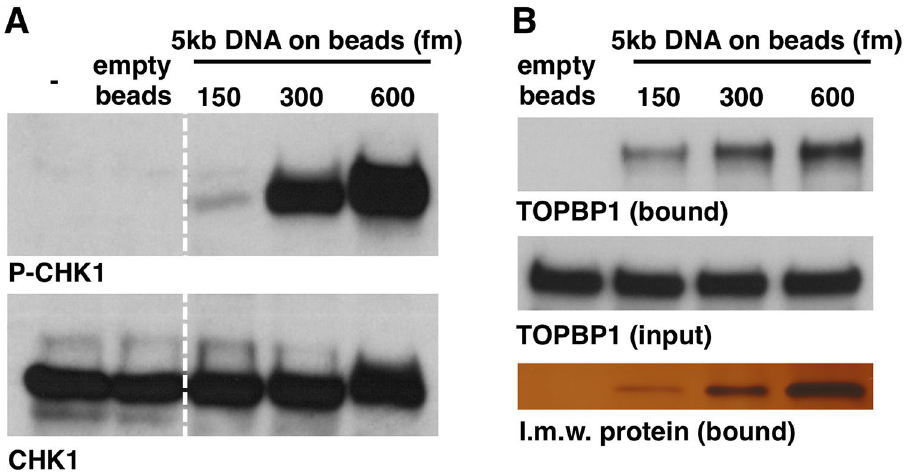
Figure 4. A DMAX-based DSB binding assay. ( A ) dsDNA (5kB) was coupled to magnetic streptavidin beads and then added to HSS at the indicated concentration of DNA. The sample labeled “–” received no beads. The sample labeled “empty beads” received only magnetic streptavidin beads. After a 60-min incubation samples were taken and probed for P-CHK1 and total CHK1. The dashed white line on the blots demarcates a lane from the original image that was removed because it is irrelevant. All samples shown were run on the same gel and blotted together on the same membrane at the same time. See Fig. S1 for the original scan. ( B ) dsDNA (5kB) was coupled to magnetic streptavidin beads and then added to HSS at the indicated concentration of DNA. One sample lacked DNA (“empty beads”). After a 60-min incubation the beads were isolated on a magnetic stand and the beads were then washed three times with PBS + 0.1% Triton X-100 and bound proteins were eluted using 2X Sample Buffer. Samples of the bound material, as well as the starting extracts (“input”) were then probed by Western blotting for TOPBP1. In addition, the bound samples were analyzed by silver staining, with a focus on a ~ 12.5 kDa low molecular weight (“l.m.w.”) showing that it is bound to the beads in a dose-dependent manner, as is